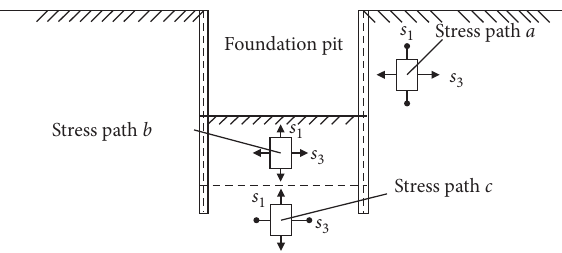
Figure 1: Distribution of stress